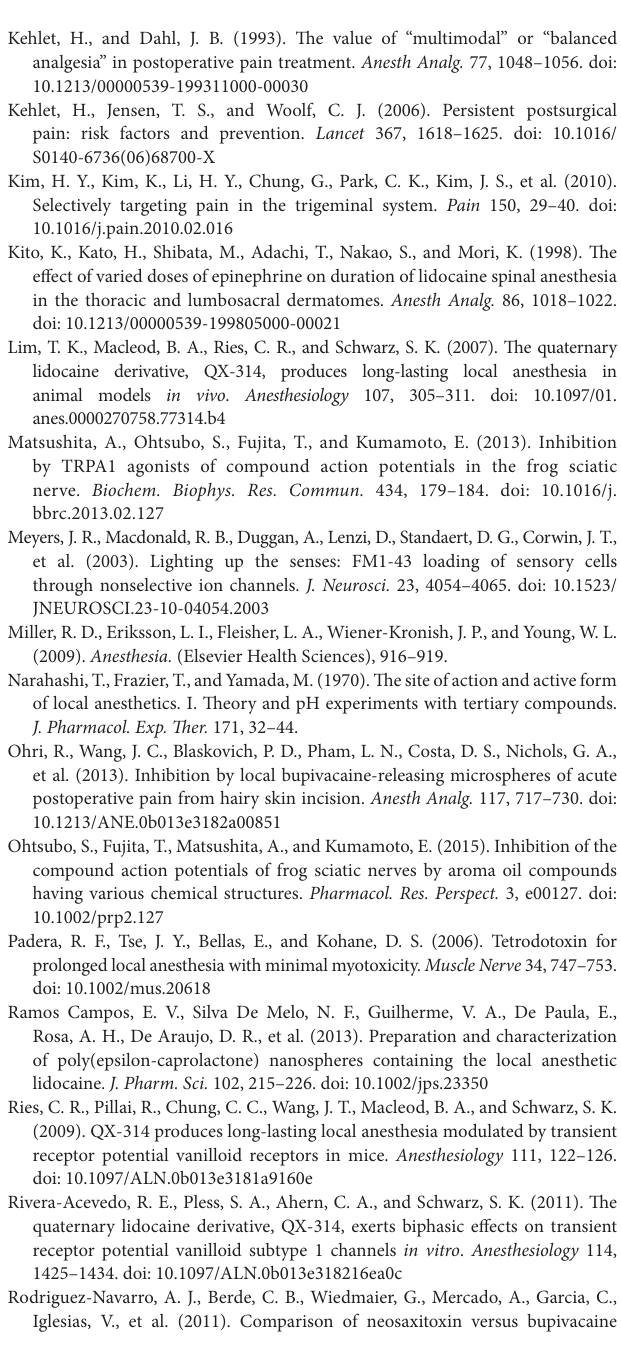
FIGURE S1 | Drug-time curve of QX-314/Levo-Bupi (35 mM/10 mM, A) and Lidocaine/Levo-Bupi (35 mM/10 mM, B) in plasma after sciatic nerve block in rats. (n = 10 in each group). Data are expressed as mean ± SEM. Levo-Bupi: